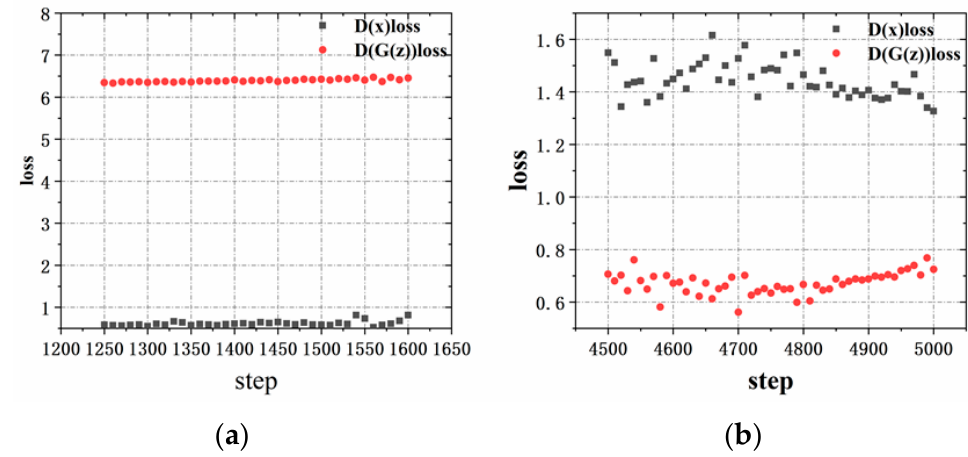
Figure 4. Generative adversarial networks training data: ( a ) 1300 training sessions; ( b ) 4500 training sessions.